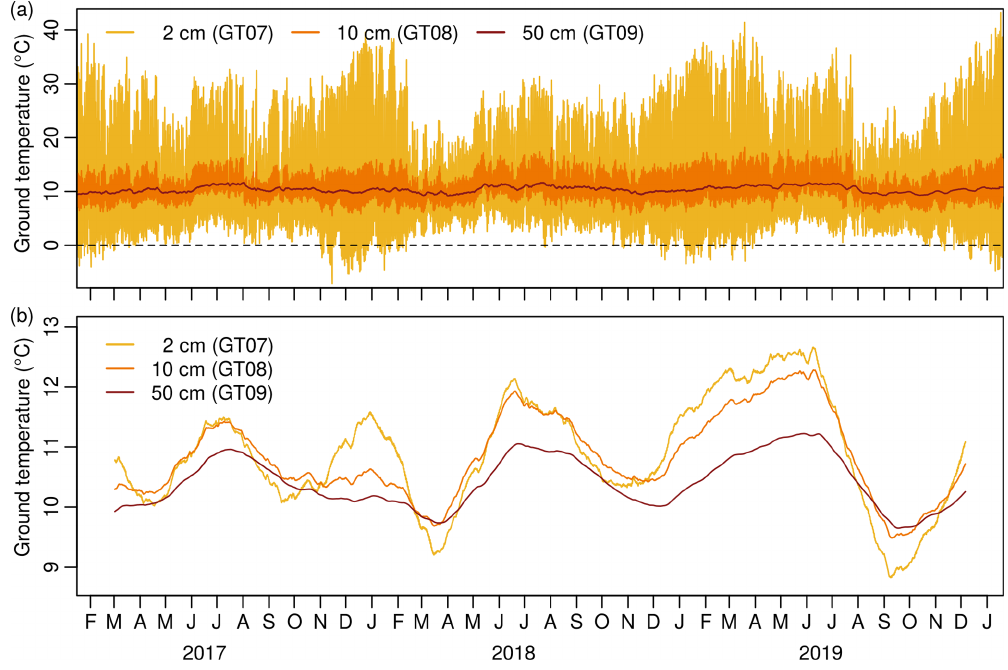
Figure 4. (a) Hourly ground temperatures at 2, 10, and 50cm depth on the southern Sanetti Plateau (3877m) from January 2017 to Jan- uary 2020. (b) Smoothed hourly ground temperatures using a simple moving average with a window size of 91d, highlighting seasonal ground temperature variations. Note that the increase of the seasonal ground temperature amplitude over the measurement period is also confirmed for other sites on the plateau and is not caused by a shift of the